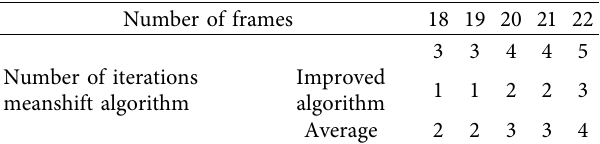
Table 1: Comparison of the number of